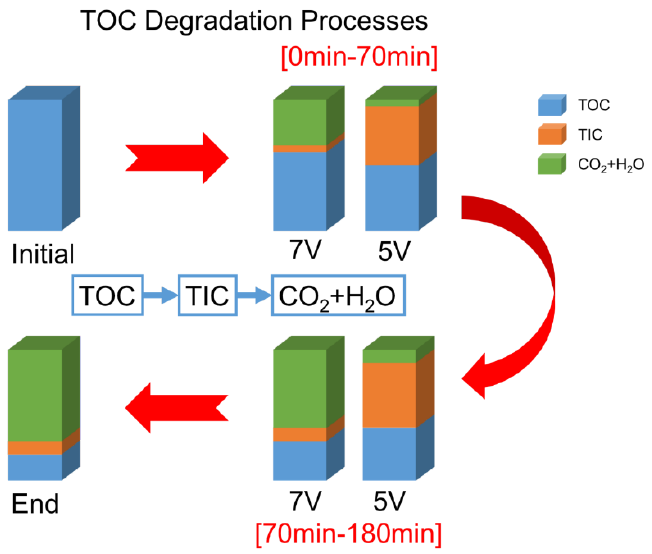
Figure 9. The diagram of TOC degradation processes in RhB wastewater with voltages of 7 V and 5 V.